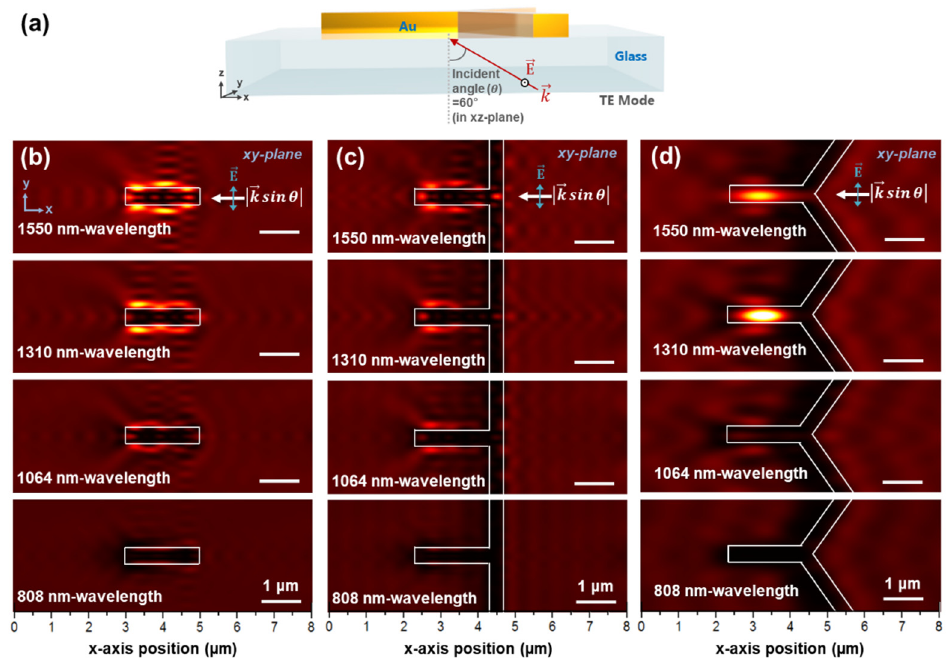
Figure 5. A front view of schematic is shown in ( a ). The TE mode of incident light at 60 incident angle degree is illustrated. Top view of calculated results of plasmonic near-field electromagnetic fields distributions for ( b ) I-, ( c ) T-and ( d ) Y-shaped nanostructure arrays by TE mode incident light with wavelengths of 1550 nm (first row), 1310 nm (second row), 1064 nm (third row), and 808 nm (fourth row) maintaining 60 angle degree of incident angle (incident angle in xz-plane). The information of incident light source is indicated in ( b ).